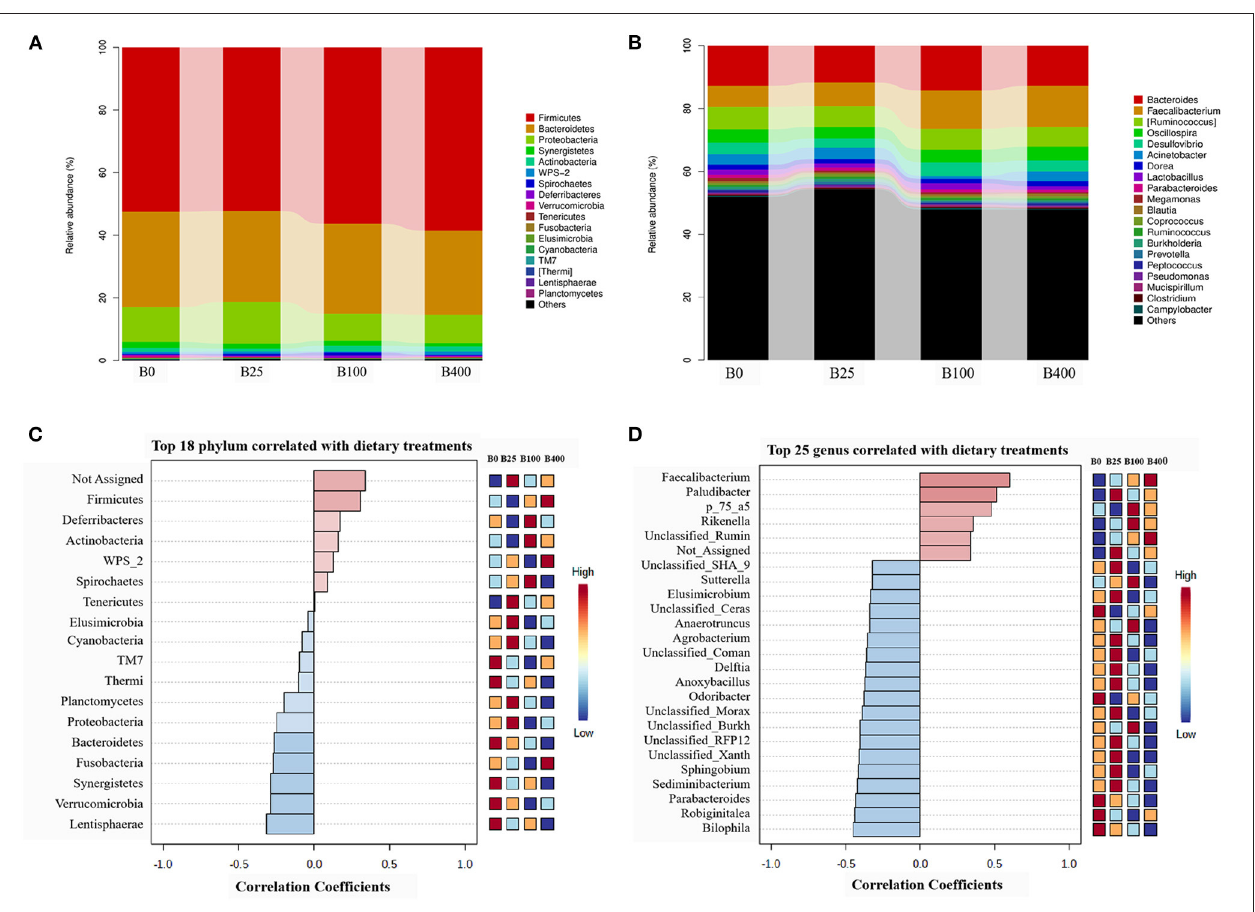
FIGURE 3 | The relative abundance of the cecal microbial composition and correlation with the dietary vitamin B 12 level at the phylum level (A,C) and the genus level (B,D)